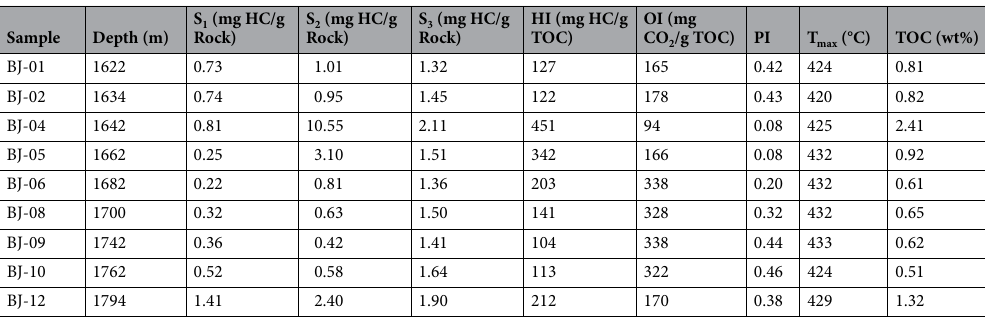
Table 3. Rock–Eval pyrolysis of Bijnot-1 well cuttings from the SR Formation.